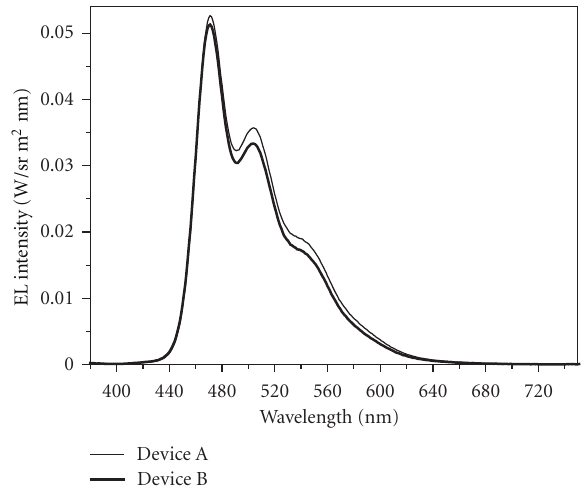
Figure 2: Electroluminescence spectra of Devices A and B mea- sured at 10 V.